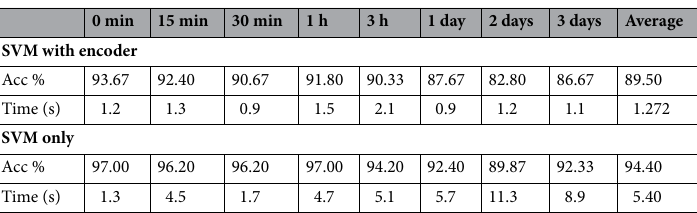
Table 1. Accuracies (average) for detecting beverage stains and processing time on the training data.